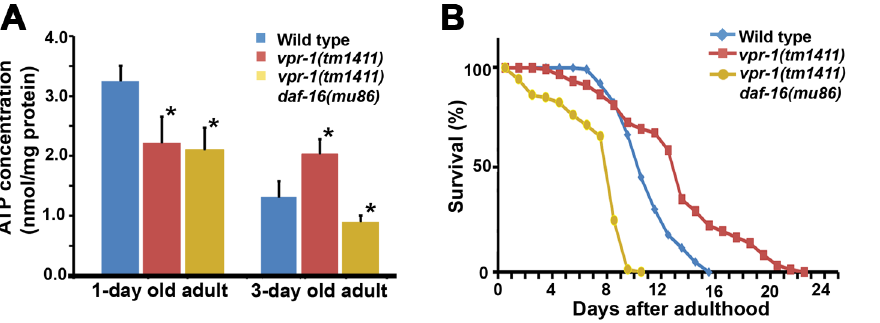
Figure 8. Effect of DAF-16 inactivation on ATP level and lifespan. (A) ATP concentration in wild-type and vpr-1(tm1411) mutant adult extracts. *, P , 0.001 compared to wild type. Error bars represent SD. ATP concentration of wild-type and vpr-1(tm1411) mutants at 1-day-old adults include published data [15] measured together with vpr-1(tm1411) daf-16(mu86) mutants. (B) Lifespan measurements of indicated genotypes. The lifespan of daf-16(mu86) mutants (not shown) was similar to the wild type, as previously shown.